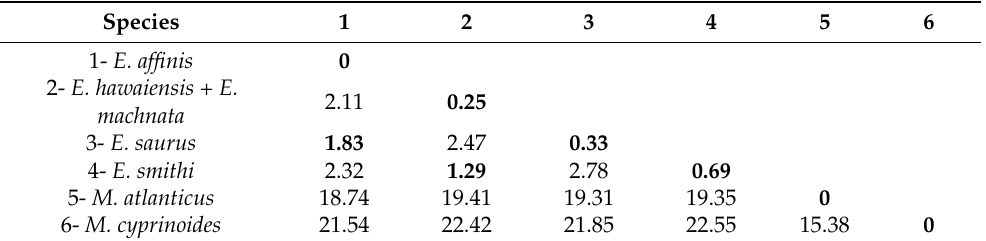
Table 2. Interspecific and intraspecific nucleotide distance (K2P) found for the COI gene of Elopidae species. The values are the percentages, and bold indicates values less than 2% (threshold).